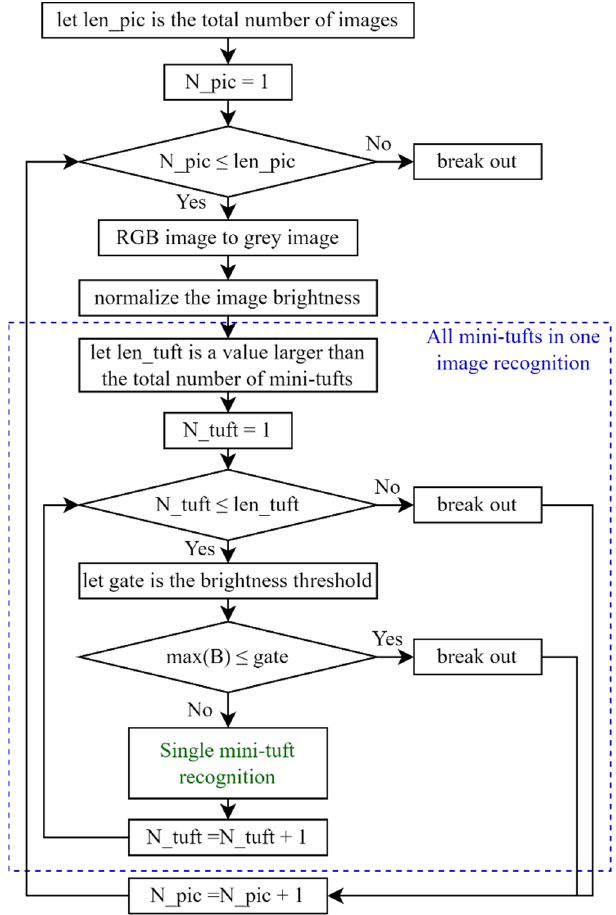
Figure 4. The process flow of luminescent mini-tufts recognition.